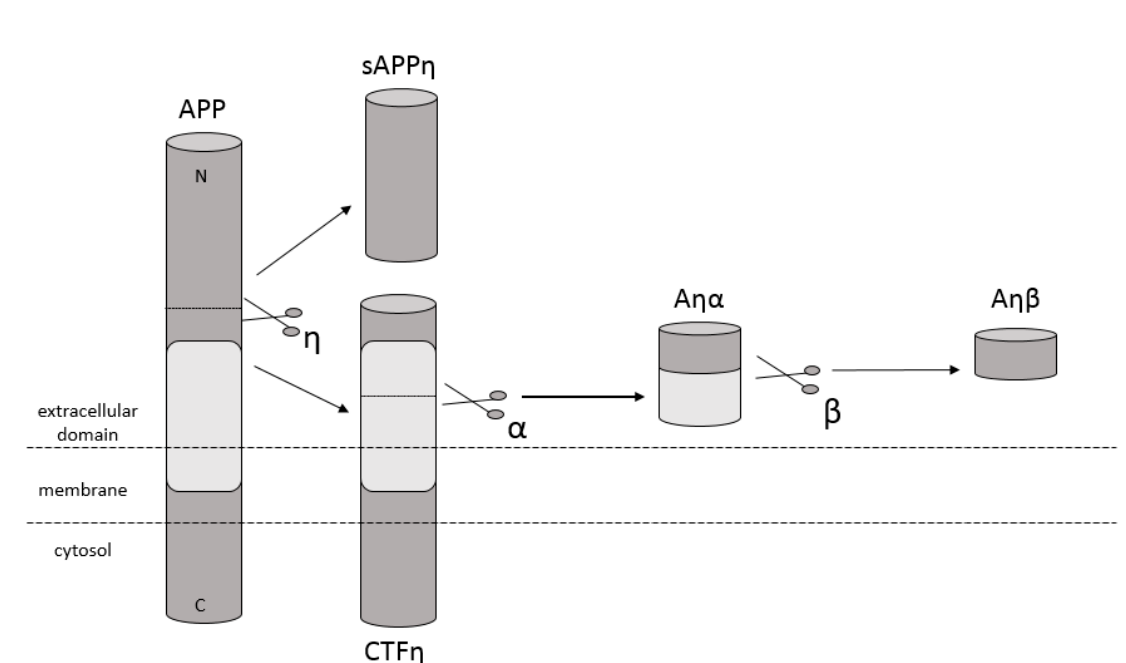
Figure 2 . Schematic diagram illustrating cleavage of APP in the amyloidogenic pathway, when APP is cleaved by β - and γ -secretase, respectively, and forms full-length A β 1–40/42 peptides. This peptide can interact with metal ions from the brain, forming A β oligomers and then A β fibrils. Based on [4].